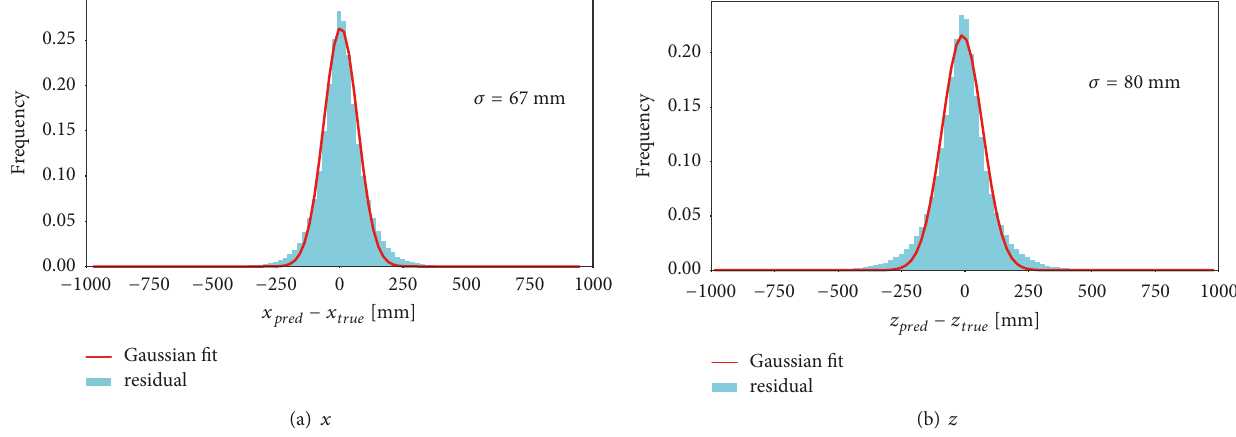
Figure 1: Residual distributions for x and z using all 192 PMT charge